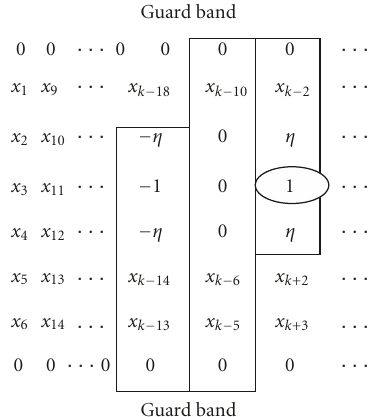
Figure 1: Channel coe ffi cients of the equivalent 1D time-varying channel model for 2PR4 target at the k th time instant, N =